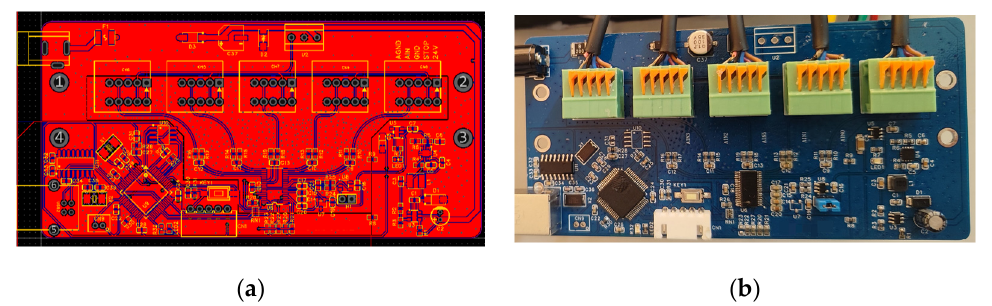
Figure 2. The schematic diagram and photo of the circuit, they should be listed as: ( a ) The schematic diagram; ( b ) the photo of the circuit.